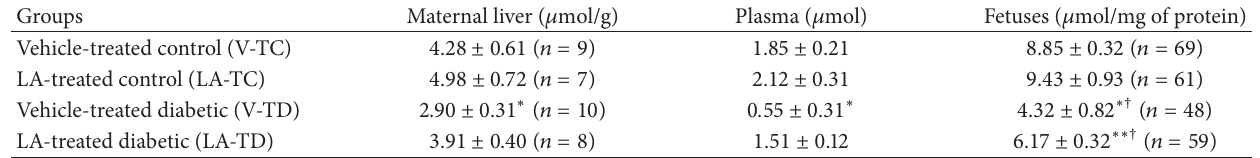
Table 4: Total glutathione content in maternal liver and plasma and in fetuses of both control and diabetic groups.